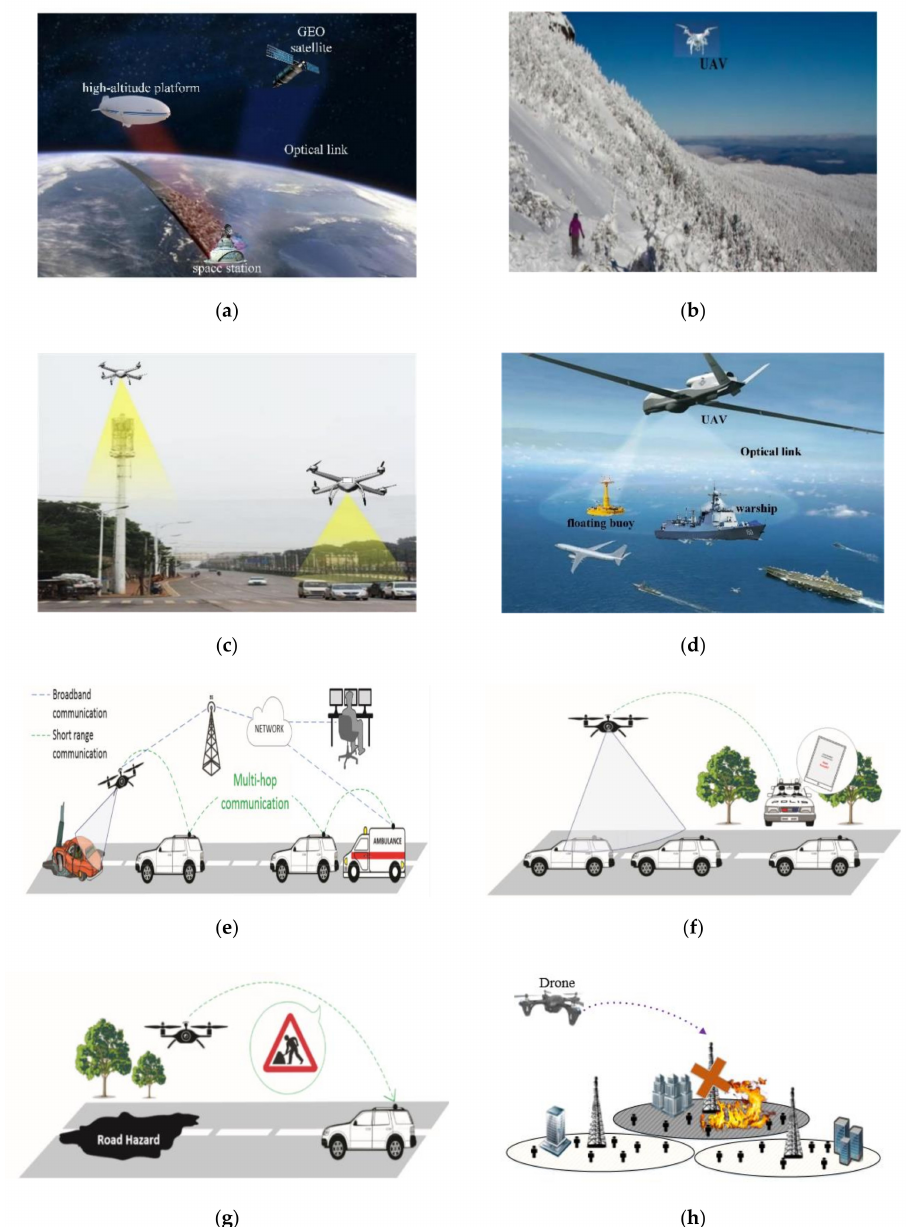
Figure 1. Unmanned aerial vehicle (UAV) application scenarios. ( a ) UAV–satellite communication; ( b ) disaster relief scene; ( c ) UAV–ground communication; ( d ) UAV–sea surface communication; ( e ) a UAV is used to provide the rescue team with an advance report prior to reaching the incident scene; ( f ) a UAV is used by police to catch tra ffi c violations; ( g ) a UAV is used as a flying roadside unit (RSU) that broadcasts a warning about road hazards that have been detected in an area not pre-equipped; and ( h ) a scene of a fire